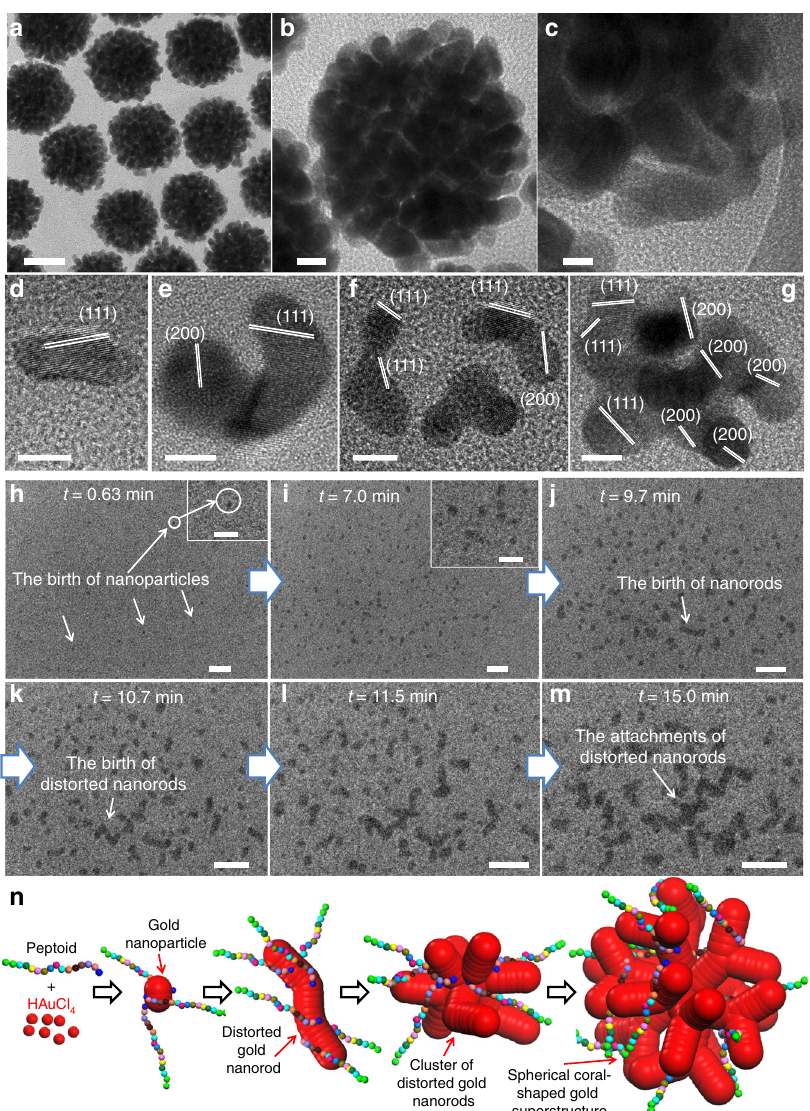
Fig. 2 Pep-1-induced formation of spherical coral-shaped gold nanoparticles. a , b TEM images with different magni fi cations showing monodispersed spherical coral-shaped nanoparticles (scale bar, 50 nm for a , 10 nm for b ). c HR-TEM revealing that the coral-shaped particles are composed of distorted nanorods (scale bar, 5.0 nm). d – g , Four high-resolution TEM images of distorted gold nanorods and clusters of nanorods formed in early stages of spherical coral-shaped particle formation, in which nanorods with (111) lattice fringes are presented ( d ) and clusters of nanorods exhibit both (111) and (200) fringes ( e – g ) (scale bar, 5.0 nm). h – m In situ liquid cell TEM time series (scale bar, 20 nm) showing the birth of gold NPs ( h , i ), nanorods ( j ), distorted nanorods ( k ), and the clusters of distorted nanorods ( l , m ) during early stages of coral-shaped particle formation; top right corner insets of h , i are the high- magni fi cation TEM images showing the gold NPs (scale bar, 10 nm). n The proposed model showing Pep- 1 -induced spherical coral-shaped